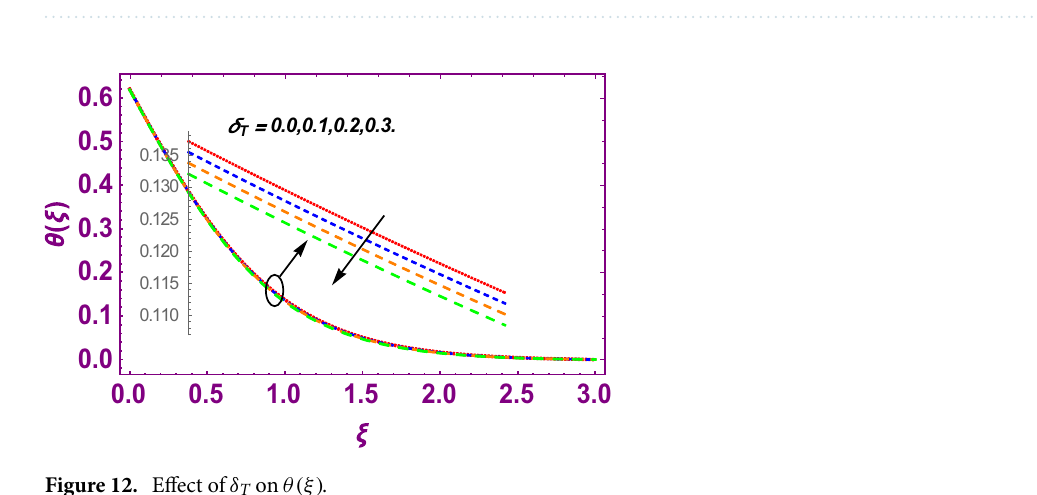
Figure 11. Influence of concentration Biot number upon φ(ξ) .